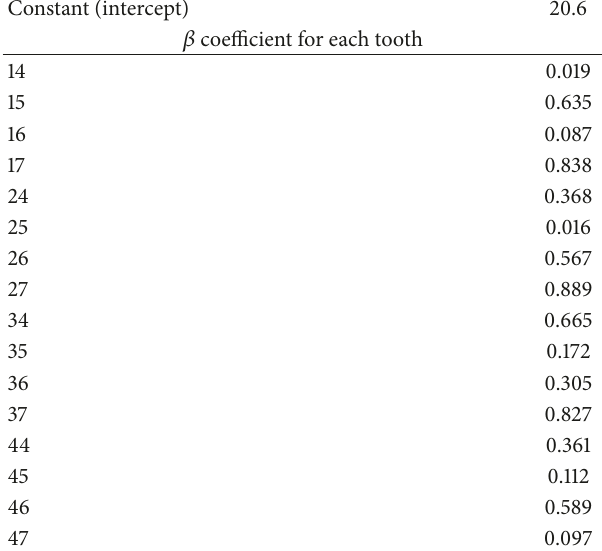
Table 7: The intercept and correlation coefficient ( 𝛽 coefficient) observed for multiple